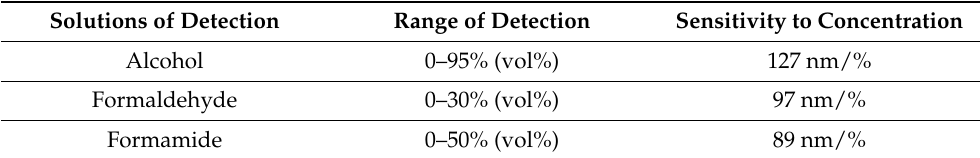
Figure 7. Schematic diagram of formaldehyde and formamide sensing performance. ( a ) SPR signal of the device with Au film against different formaldehyde concentrations. ( b ) Linear fit of the device with Au films against different formaldehyde concentrations. ( c ) SPR signal of the device with ZnO nanoflowers/Au structure against different formaldehyde concentrations. ( d ) Linear fit of the device with ZnO nanoflowers/Au structure against different formaldehyde concentration. ( e ) SPR signal of the device with Au film against different formamide concentrations. ( f ) Linear fit of the device with Au films against different formamide concentrations. ( g ) SPR signal of the device with ZnO nanoflowers/Au structure against different formamide concentrations. ( h ) Linear fit of the device with ZnO nanoflowers/Au structure against different formamide concentrations. Table 1. Comparison of the performance of three solutions.